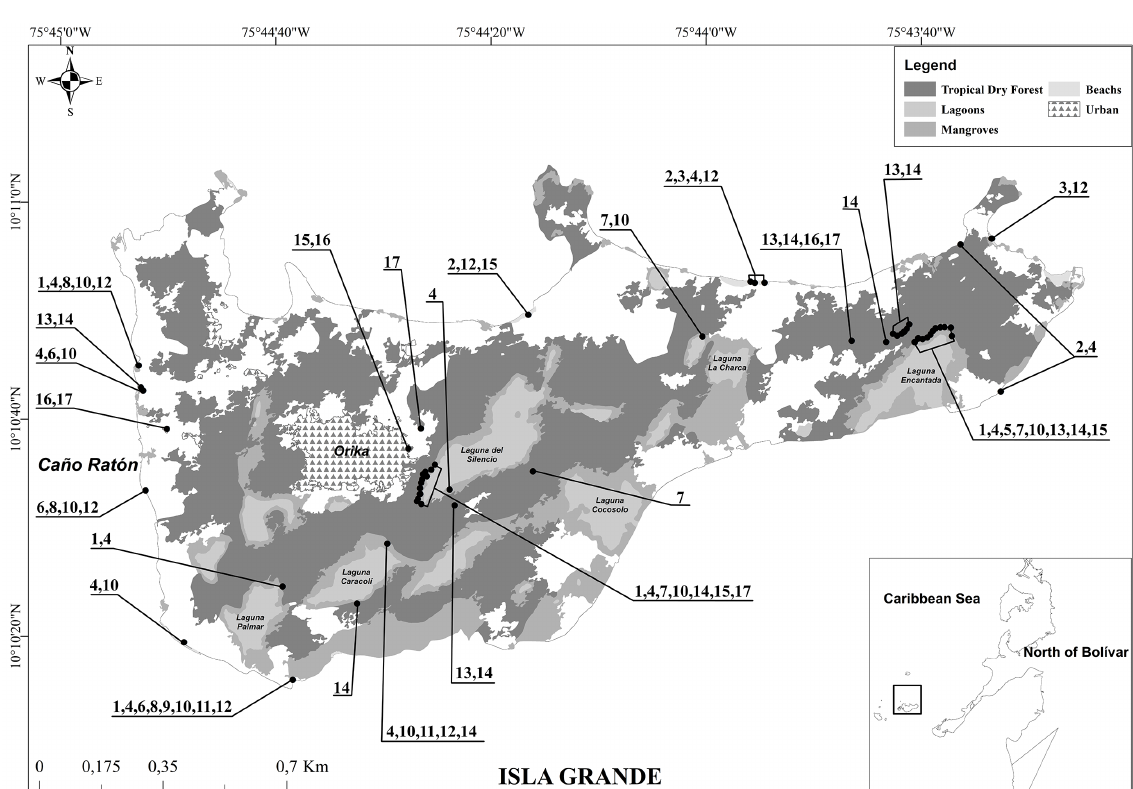
Fig. 1. Map of the study areas and distribution of species of terrestrial isopods from Isla Grande. 1 .